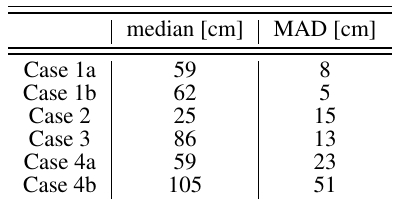
Table 1. 2D positioning results. LiDAR refers only to those time instants when the Pedestrian were detectable (e.g. not